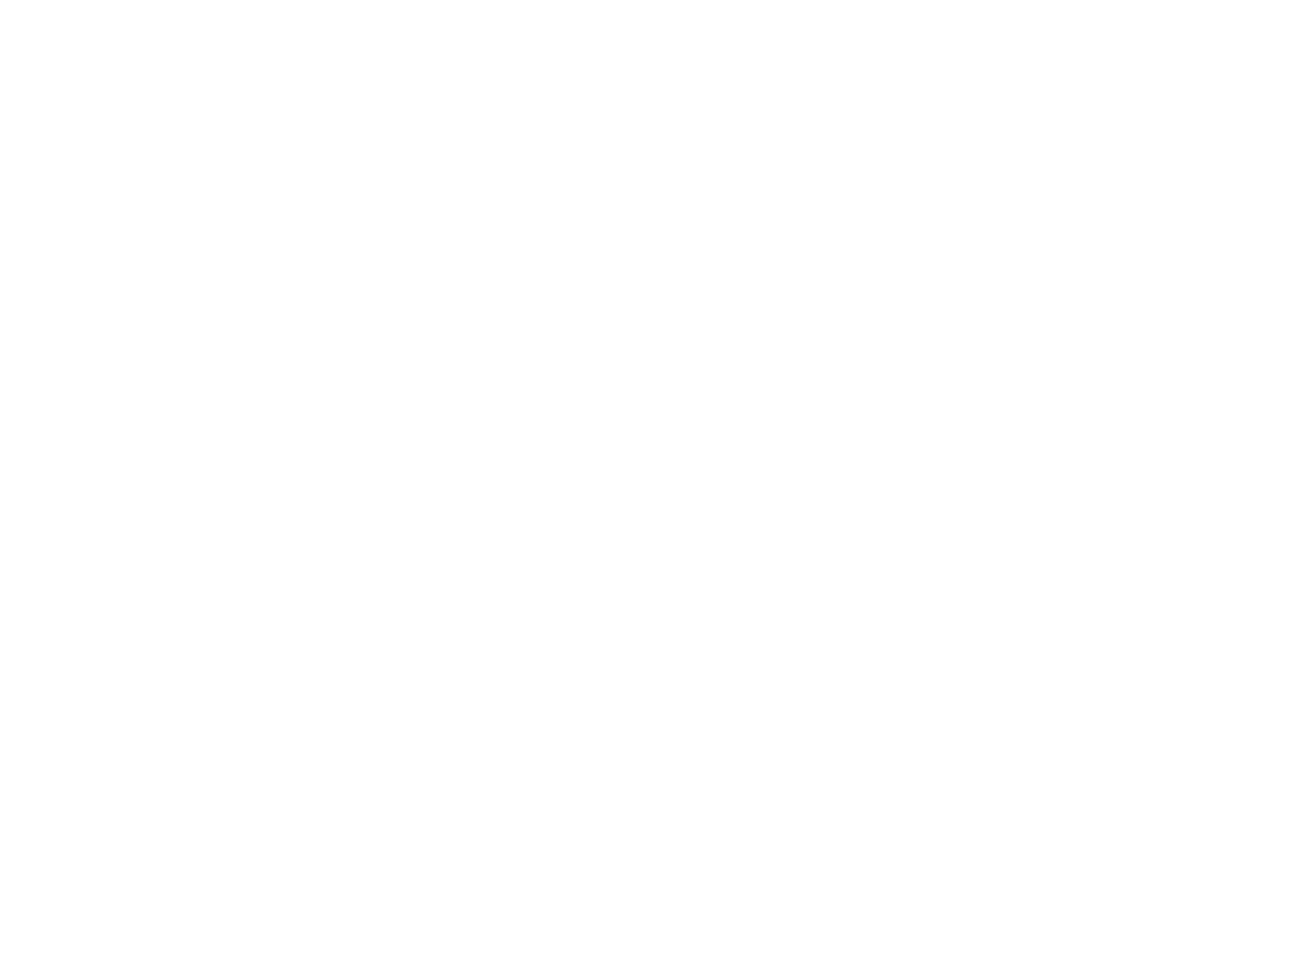
Frontiers in Materials |